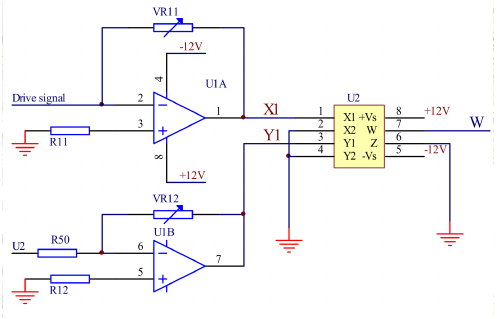
Figure 8. The variable gain amplification